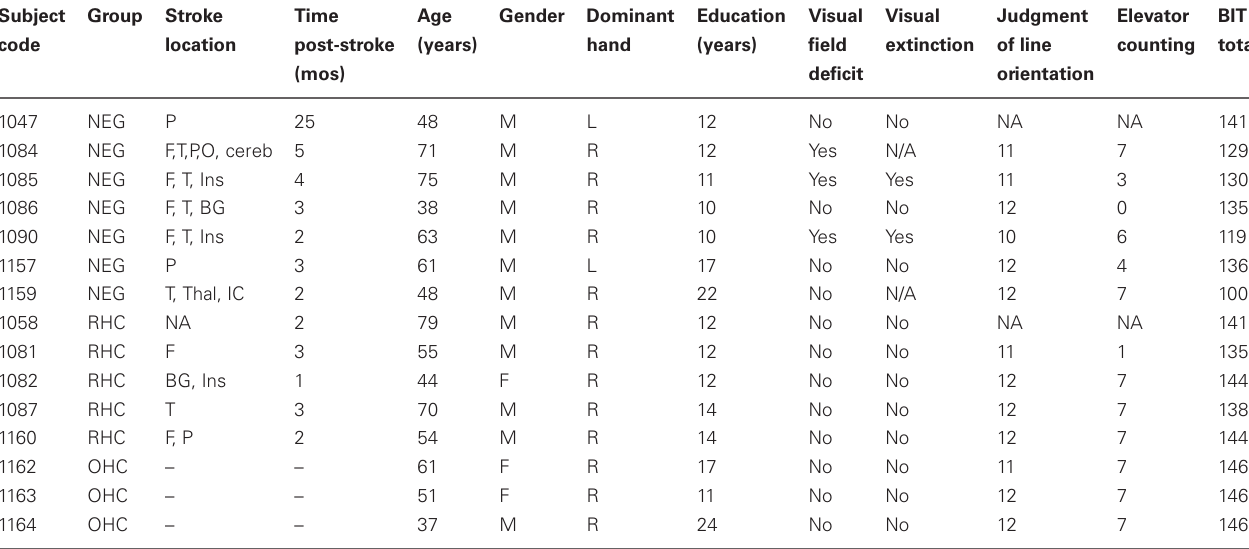
Table 2 | Demographic and baseline neuropsychological assessment.